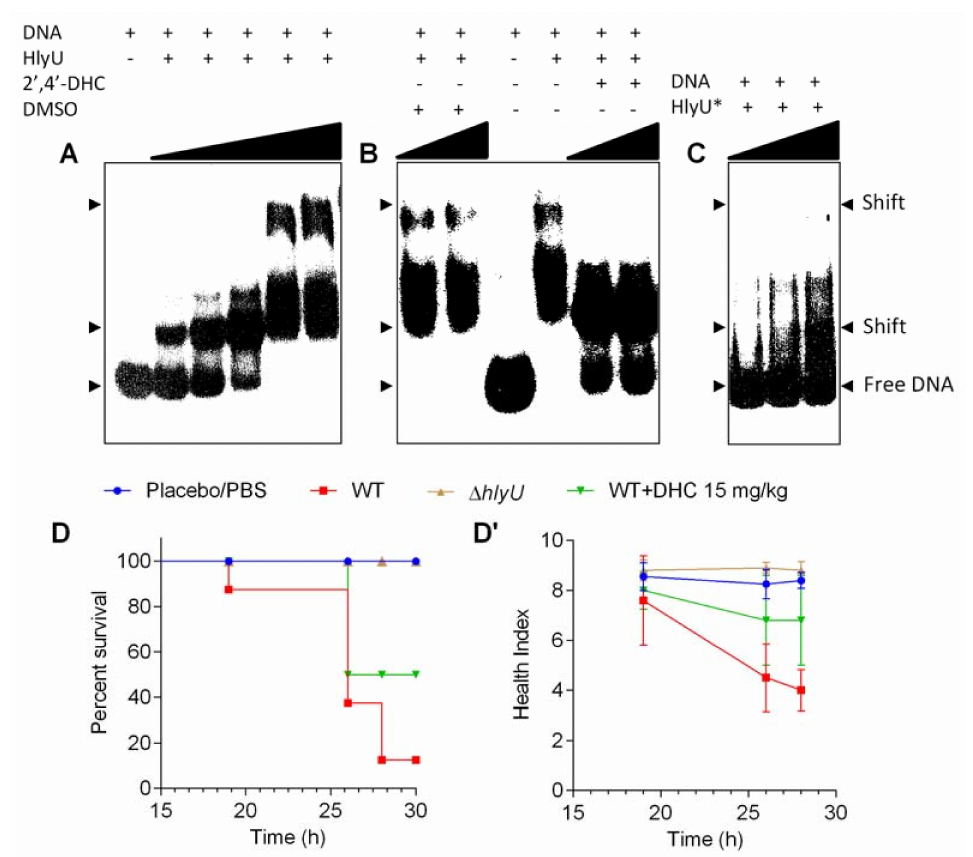
Figure 4. Electrophoretic mobility shift assay and in vivo validation of 2 (cid:48) ,4 (cid:48) -DHC with G. mellonella infection model. ( A ) Titration of 3 nM (261 bp) P rtxA 1 DNA test probe with increasing concentrations (25, 50, 100, 150 and 300 nM) of HlyU protein. ( B ) Effect of 2 (cid:48) ,4 (cid:48) -DHC on HlyU binding to cognate P rtxA 1 DNA. A total of 150 nM HlyU protein was incubated with varying concentrations of 2 (cid:48) ,4 (cid:48) -DHC (150 and 300 µ M) or DMSO control for 15 min and then DNA was added. ( C ) Interaction of HlyU dimerization mutant L91A/L17A protein (HlyU*) with the P rtxA 1 DNA test probe. The concentrations of HlyU* were 40, 100 and 200 nM. The DNA protein mixtures were incubated for 20 min at room temperature (25 ± 2 ◦ C) in 1 × binding buffer, before loading onto 6% DNA retardation gel. Free DNA and shifts are indicated with arrow heads. ( D ) Kaplan–Meier survival curves of G. mellonella larvae treated with 15 mg/kg of 2 (cid:48) ,4 (cid:48) -DHC or controls in the V. vulnificus infection model. ( D’ ) Health index of larvae plotted as the average of every group (10 larvae/group) at each time